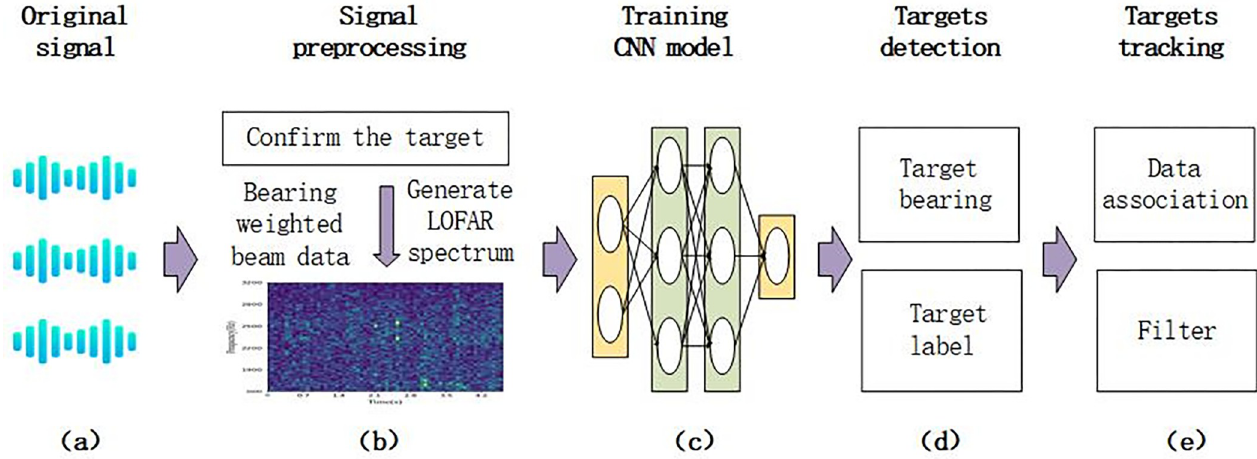
Fig 1. Framework and process flow in the MLDE method. (a) shows the raw sonar array signal. (b) is the pre-processing of the data after confirming the target, azimuth weighting, and generating the multi-beam LOFAR spectrum, which can be used for CNN model training. (c) is the training of the CNN model. (d) The trained CNN model is used to identify the target and give the azimuth measurements. (e) The azimuth measurements and the trajectory are correlated and filtered by EKF.